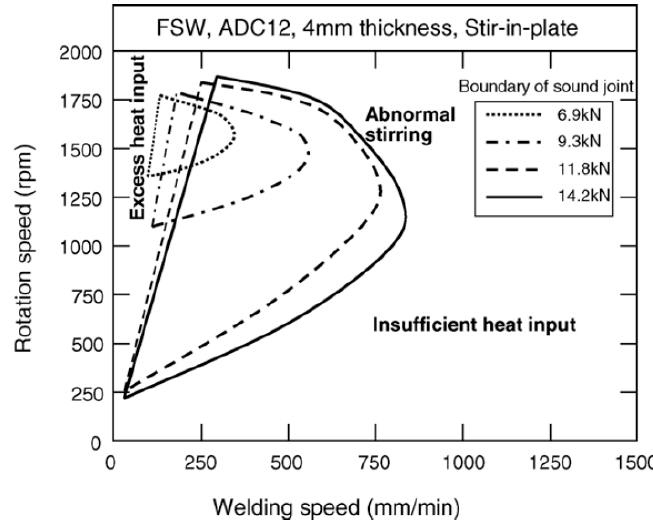
Figure 3. Tool rotation versus traverse welding speed showing heat generation. Reproduced with permission from [37], Elsevier, 2006.